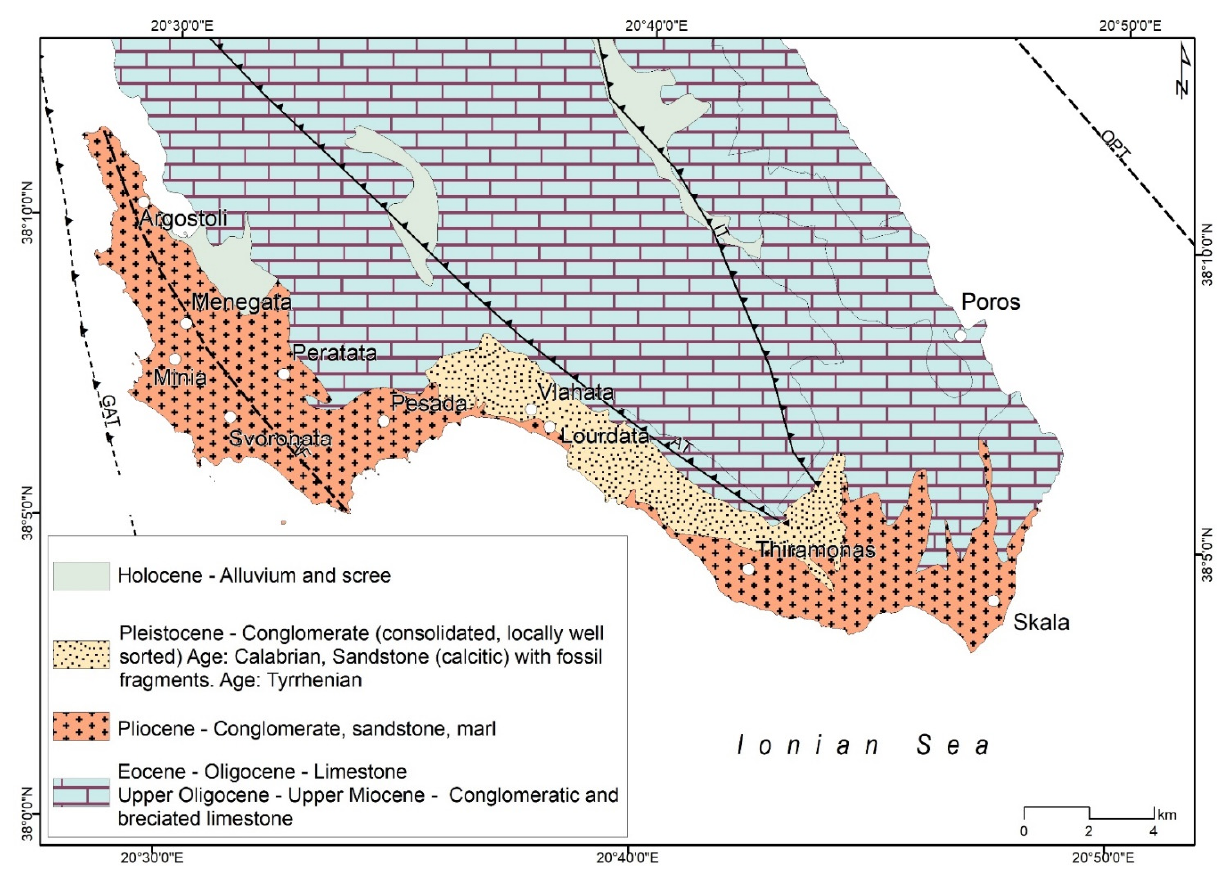
Figure 2. Simplified geology of the investigated area. GAT: Gulf of Argostoli Thrust, AF: Argostoli Fault, AT: Ainos Thrust, IT: Ionian Thrust, OPT: Offshore Poros Thrust.